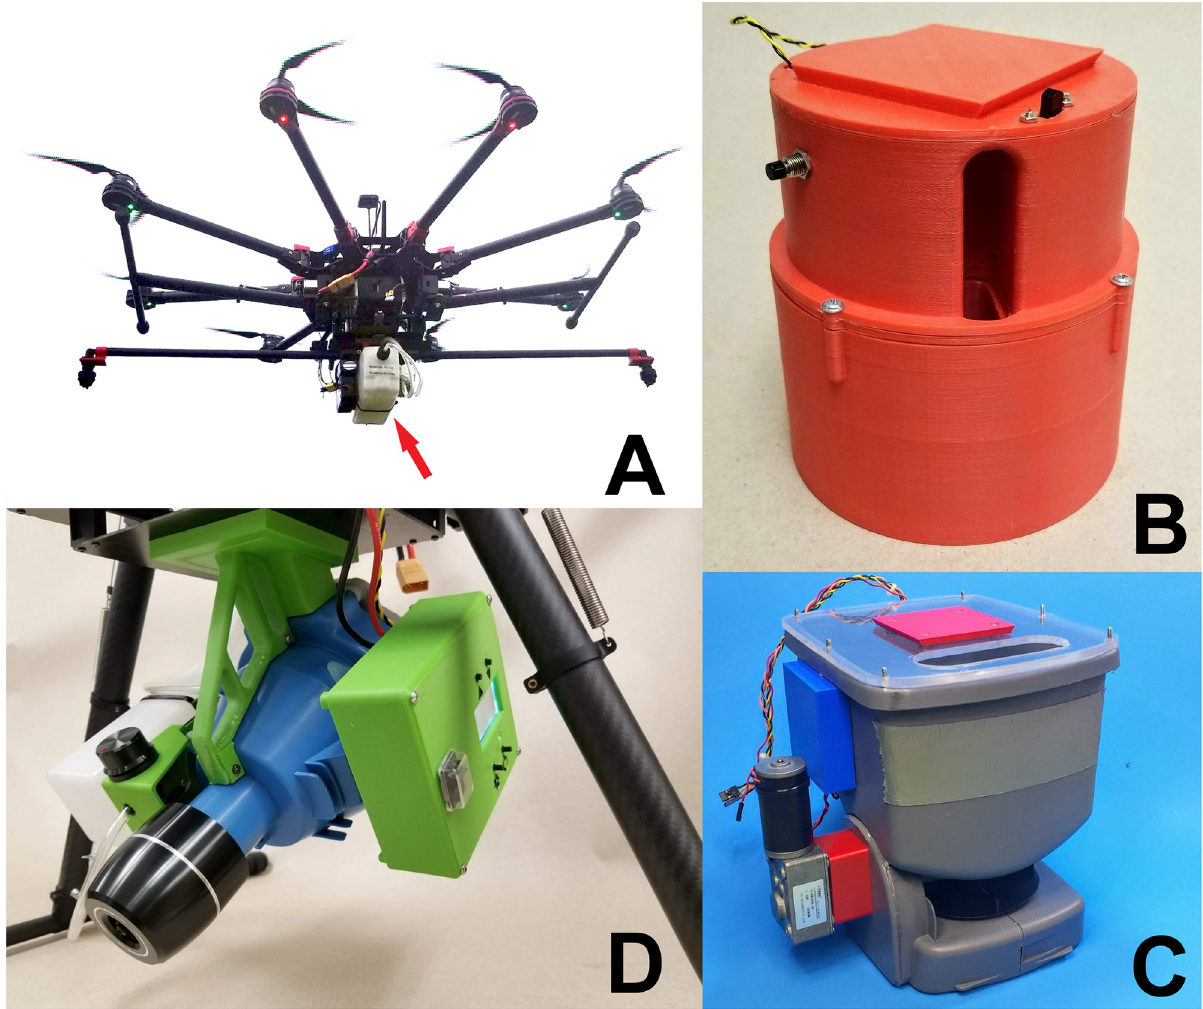
Fig 1. A. DJI S1000+ UAS and spray module (arrow) for dispensing liquid larvicides. B. Dispenser module for dropping Natular XRT tablets from a UAS. C. Modified hand spreader module for the application of larvicidal granules from a UAS. D. Longray ultra-low volume spray module for mosquito adulticide application from a